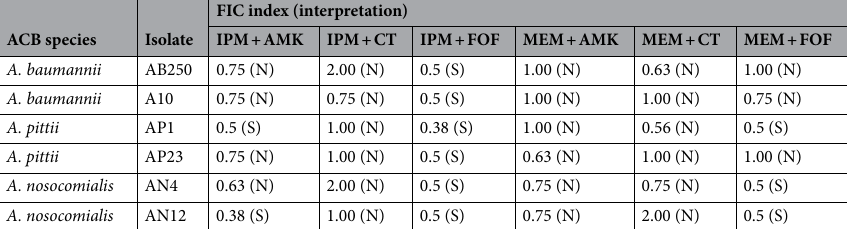
Table 3. The activity of carbapenems, imipenem (IPM) and meropenem (MEM), in combination with amikacin (AMK), colistin (CT), or fosfomycin (FOF) performed by checkerboard assay. The FIC index was calculated and interpreted as synergism (S) and no interaction